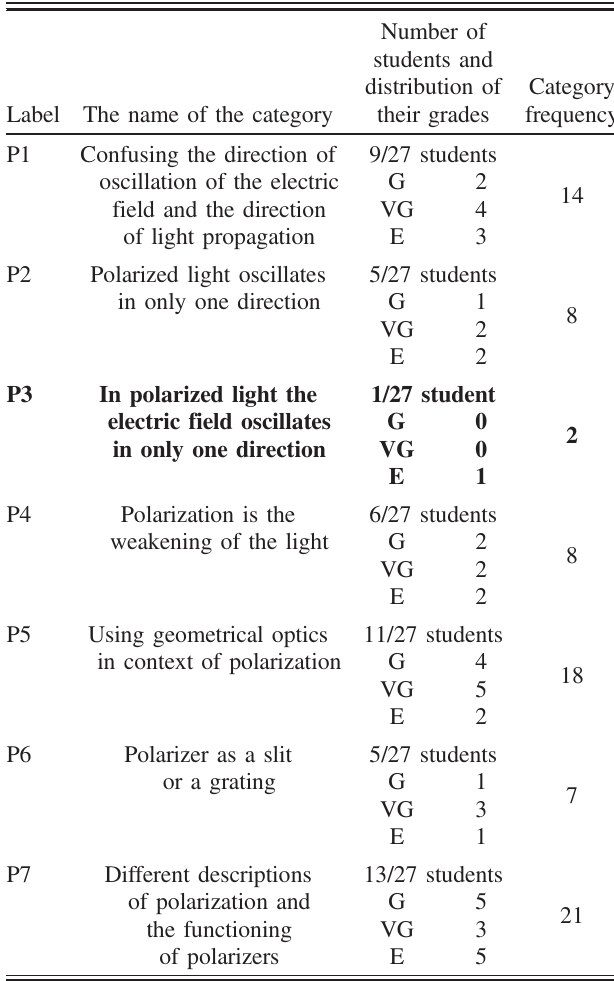
TABLE II. Categories of students ’ reasoning strategies